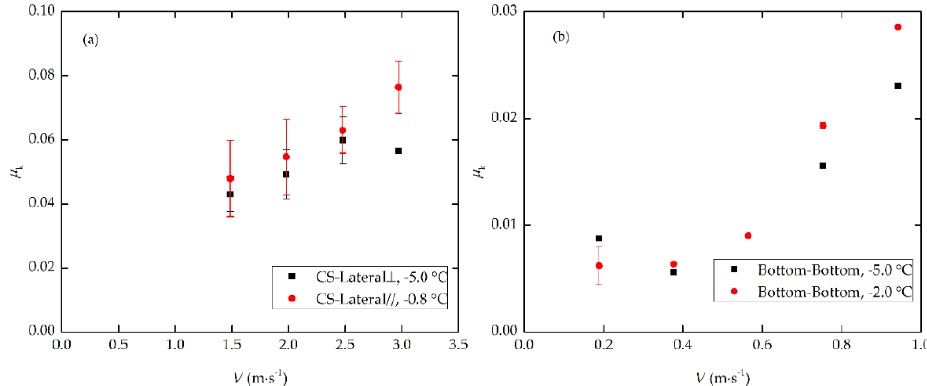
Figure 11. Variations of µ k with velocity under different air temperatures for: ( a ) CS-Lateral ⊥ and CS-Lateral//; ( b ) Bottom-Bottom. The data were averaged over all normal stresses, and the error bars represent the standard deviation.